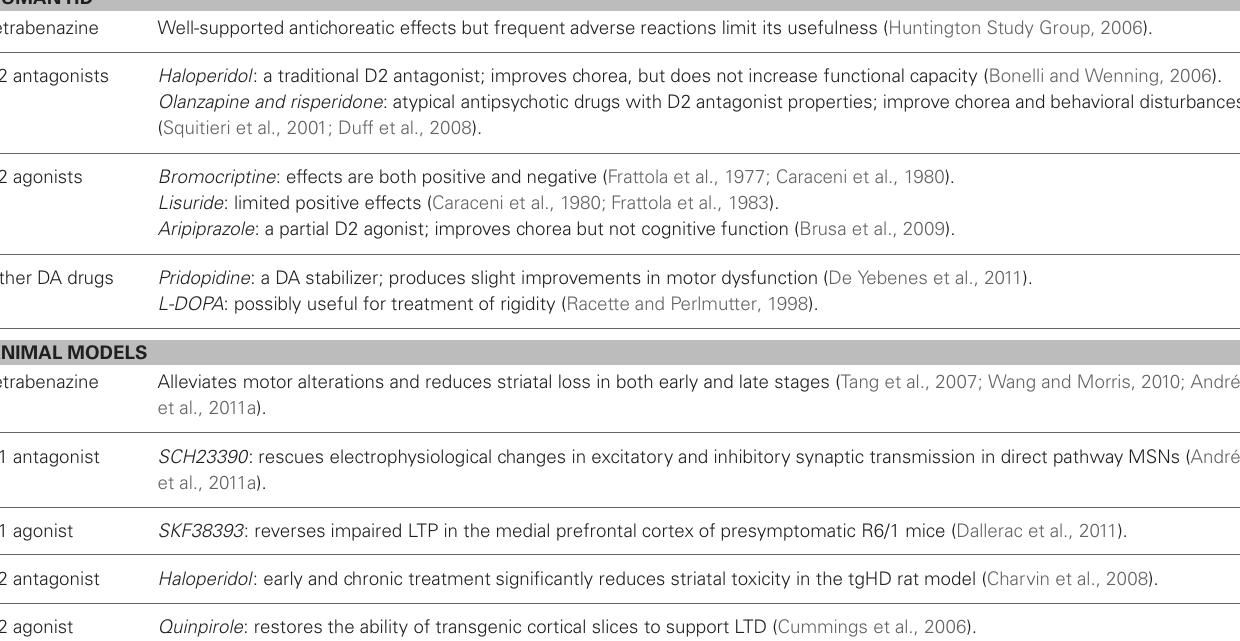
Table 2 | Available and potential